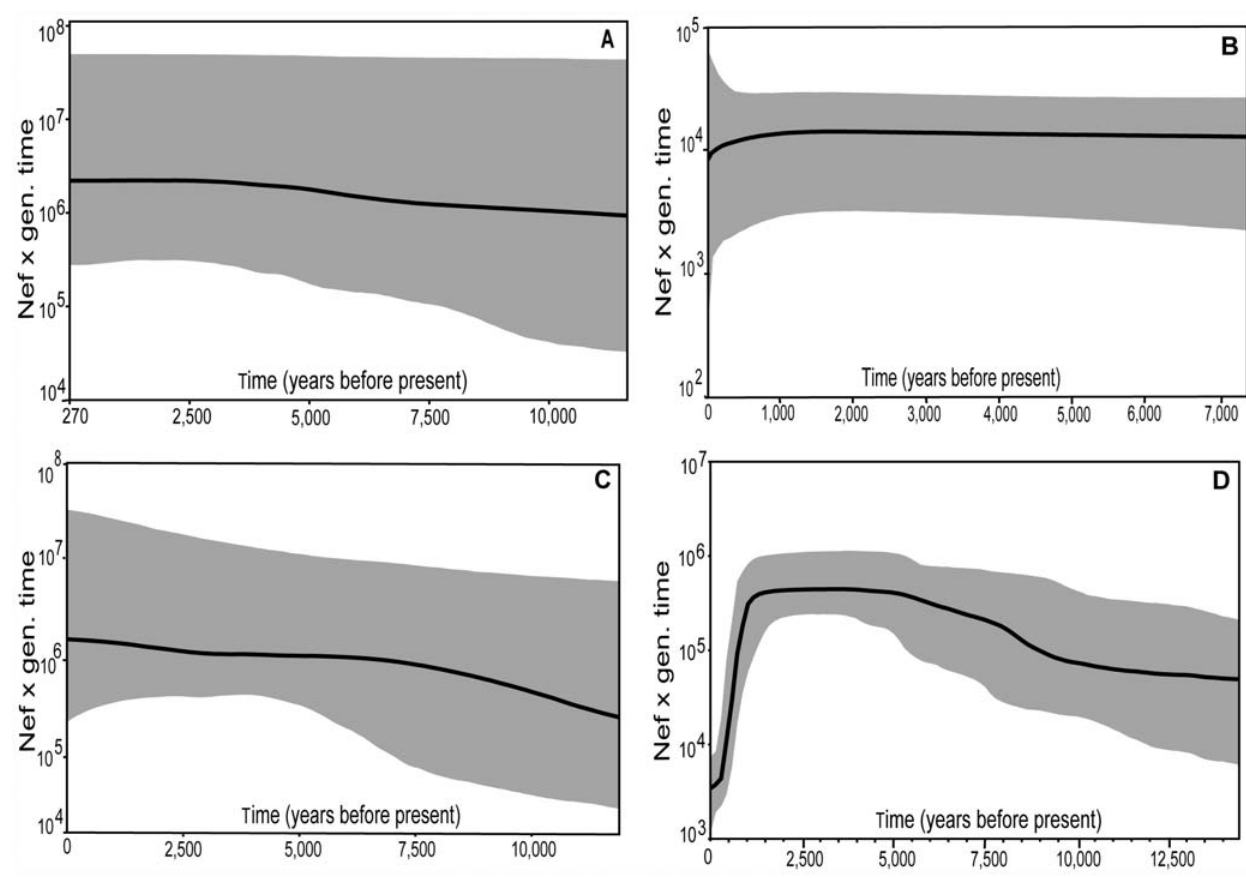
Figure 4. Bayesian skyline plots of effective population size change through time. The black line indicates the median posterior effective population size through time. The gray lines illustrate the 95% HPDI, taking into account coalescent model and phylogenetic uncertainty, for: (A) VLC alone; (B) MQ alone; (C) VLC and Marion Island combined; (D) VLC and MQ combined.